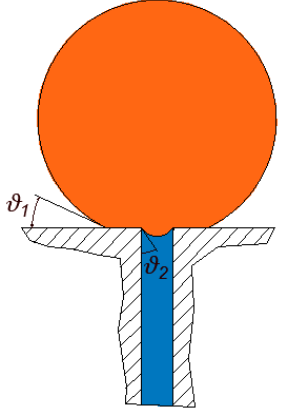
Figure 4. The wettability conditions at the surface of the membrane and inside the pores may be different. In such a case, the contact angles that the two interfaces make are different.